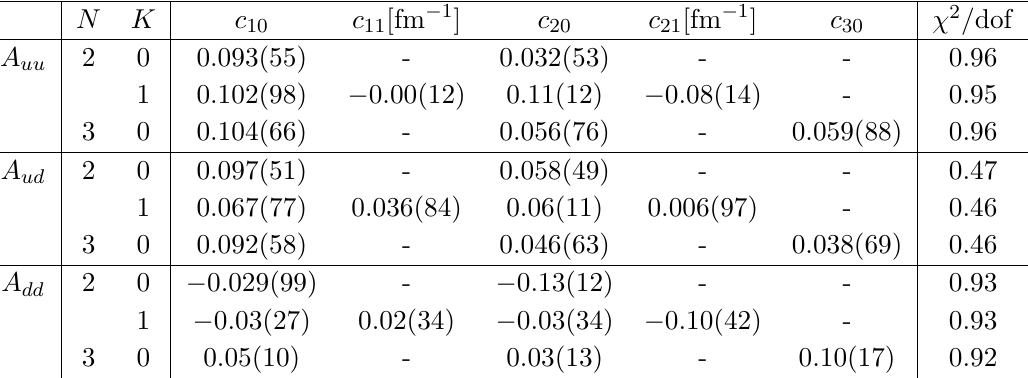
Table 7 . Fit results for the parameters c mk of our global fit ansatz (4.17) obtained for the unpo- larized channels A , A and A . We take into account ( N, K ) = (2 , 0) , (2 , 1) , (3 , 0) uu ud dd